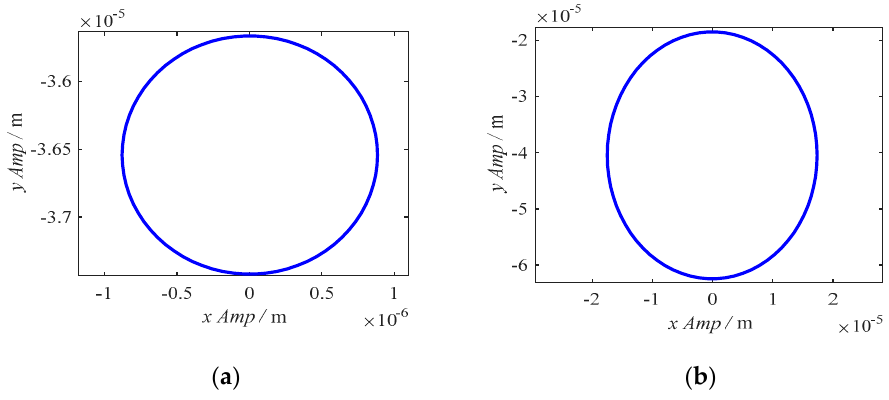
Figure 2. The axis orbits of normal and cracked rotors: ( a ) µ = 0, ( b ) µ = 0.2.